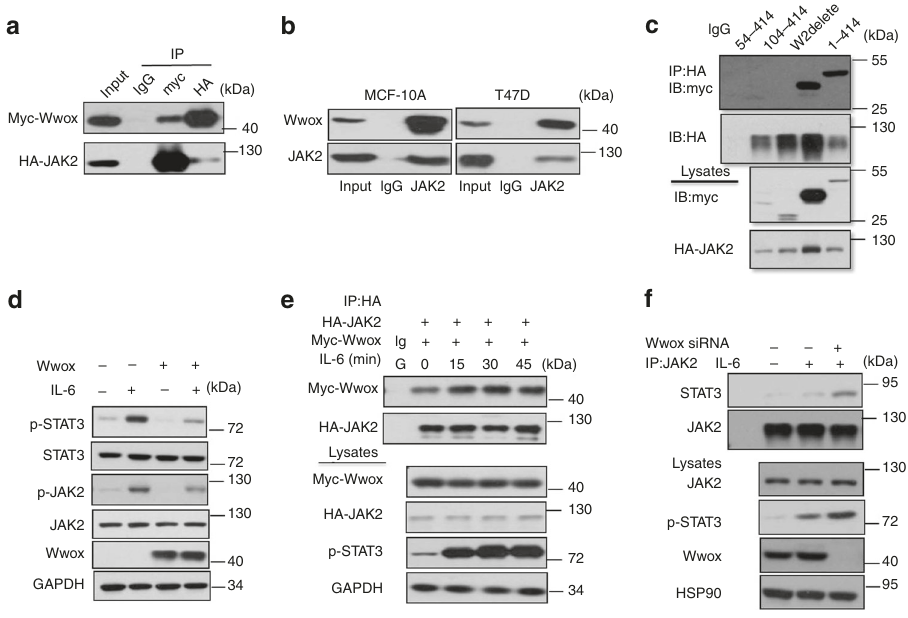
Fig. 4 Wwox inhibits the interaction of JAK2 and STAT3. a Co-immunoprecipitation of Wwox and JAK2 shows Wwox – JAK2 interaction. 293T cells were transfected with plasmids expressing Myc-tagged full-length Wwox or HA-tagged full-length JAK2, as indicated. Whole-cell lysates were used in immunoprecipitation (IP) with anti-Myc antibody or anti-HA antibody. b Endogenous Wwox and JAK2 interact in vivo. Lysates of MCF-10A and T47D cells were subjected to IP with anti-JAK2 antibodies. c Wwox interacts with JAK2 mainly through the WW1 domain. IP and immunoblot (IB) of cell lysates from 293T cells expressing HA-tagged STAT3 and Myc-tagged Wwox or Myc-tagged truncated Wwox proteins (illustrated in Supplementary Fig. 5). Whole- cell lysates were immunoprecipitated with anti-HA and immunoblotted with anti-Myc antibody. d Wwox reduces p-STAT3 and p-JAK2 levels. MDA-MB- 231 cells were transfected with Wwox plasmids and were treated with IL-6 for 30 min. The whole-cell lysates were immunoblotted with the indicated antibodies. e Interaction pattern of Wwox and JAK2 under IL-6 stimulation. IP and IB of cell lysates from 293T cells expressing HA-tagged JAK2 and Myc- tagged Wwox; cells were treated with IL-6 for the indicated time spans. f Wwox inhibits the interaction of JAK2 with STAT3. MCF-7 cells were transfected with Wwox siRNA, along with IL-6 stimulation; cell lysates were subjected to IP and IB